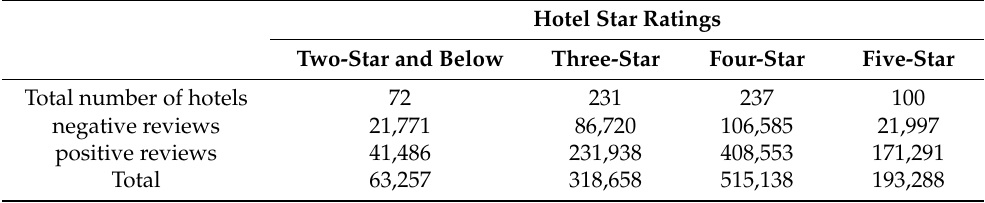
Table 2. Distribution of sub-datasets according to the hotel star and overall customer ratings. Hotel Star Ratings Two-Star and Below Three-Star Four-Star Five-Star Total number of